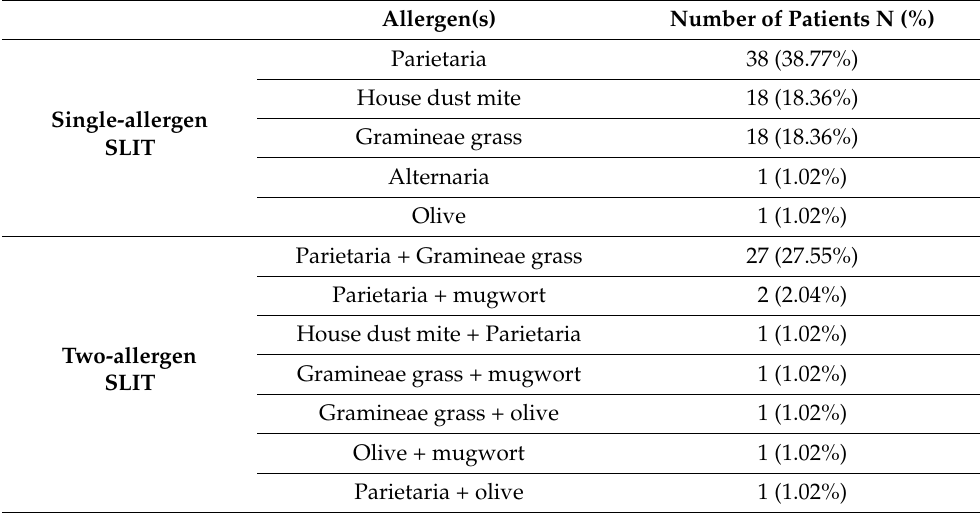
Table 3. Allergen(s) used for sublingual immunotherapy